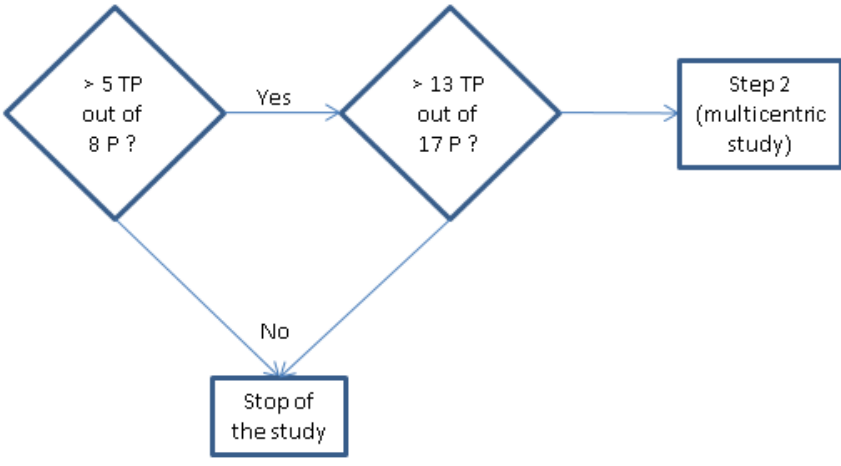
Figure 3. Decision diagram for 2-step study plan. True-positive patients required in stage 1 and stage 2 of the monocentric study to proceed to the multicentric study (step 2). P: patients; TP: true positive.